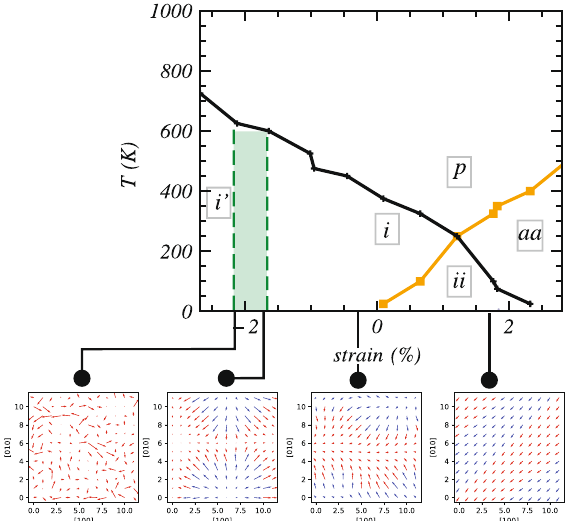
Fig. 1 Phase diagram of SL. Phase diagram of SL, with multidomain out-of-plane polar phase i , monodomain out-of-plane polar phase i 0 , orthorhombic polar phase with in-plane polarization aa , phase ii having both in-plane polarization and out-of-plane polar domains, and high-temperature paraelectric phase p . The black and yellow lines separate these phases. The green shaded area demarcates the stability region of polar nanobubbles. In-plane dipolar patterns are depicted for − 2.02, − 1.56, − 0.45 and 1.77% epitaxial strains at 5 K and shows up (red) and down (blue) dipoles. Both in-plane and out- of-plane dipole patterns can be found in Supplementary Fig. 1.